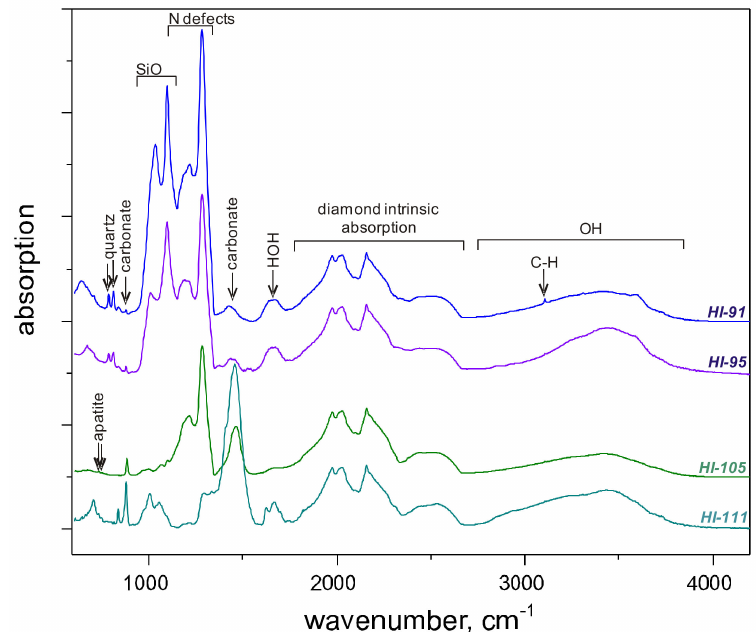
Figure 3. FTIR spectra of diamonds from placers in the northeastern Siberian craton with carbonate-dominated (HI-105 and HI-111) and silicate-dominated (HI-91 and HI-95) microinclusions. Seven individual microinclusions ranging in size from 50 to 300 nm have been studied in HI-91, and nine microinclusions in HI-95. All microinclusions are represented by polyphase associations. The phases are identified by chemical composition, and some of them by di ff raction data. Representative TEM images of microinclusions and energy dispersive spectroscopy (EDS) spectra of common phases in Al-rich silicic microinclusions are shown in Figure 4. As carbonates are not stable under an electron beam, the information on carbonates was obtained using electron energy loss spectroscopy (EELS) and EDS with nanometer